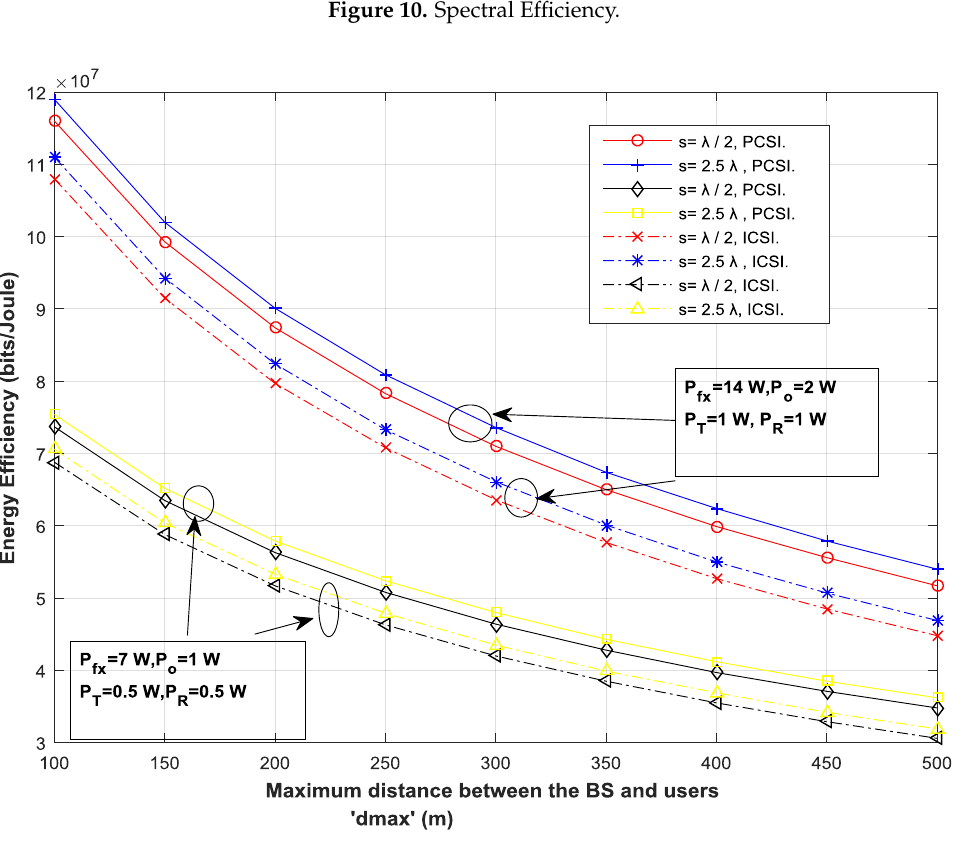
Figure 11. Energy Efficiency.